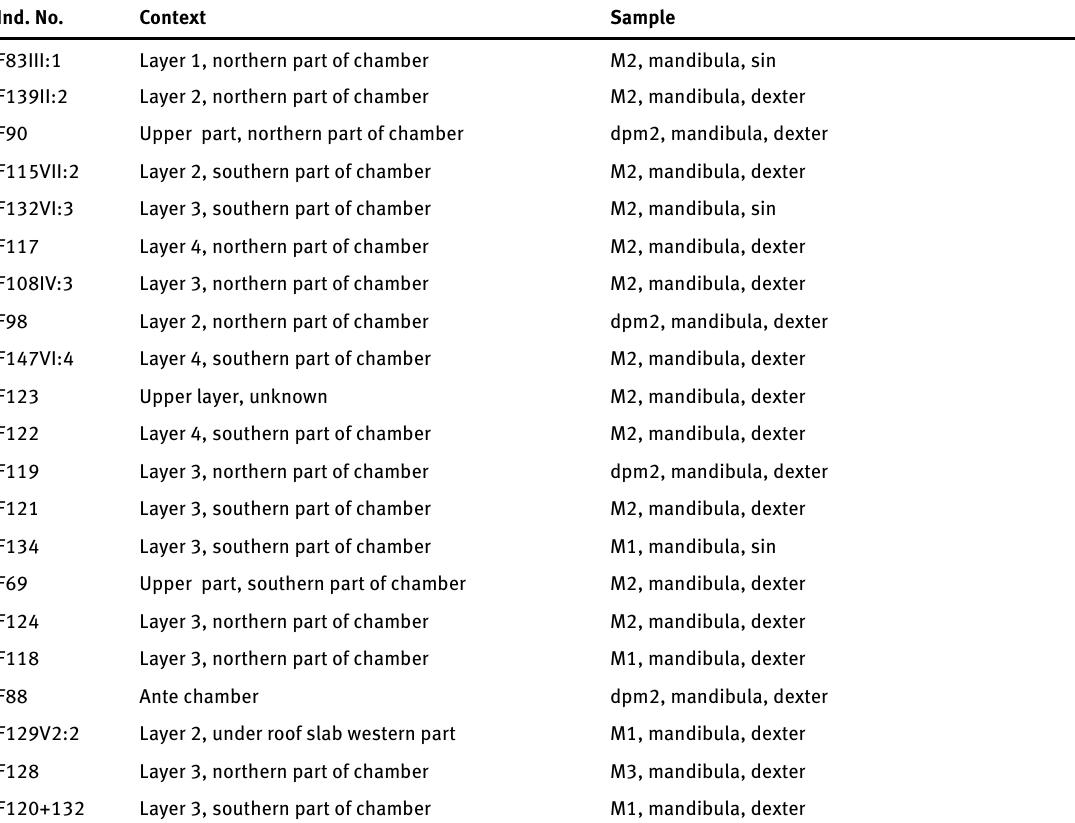
Table 1. Individuals sampled for isotope